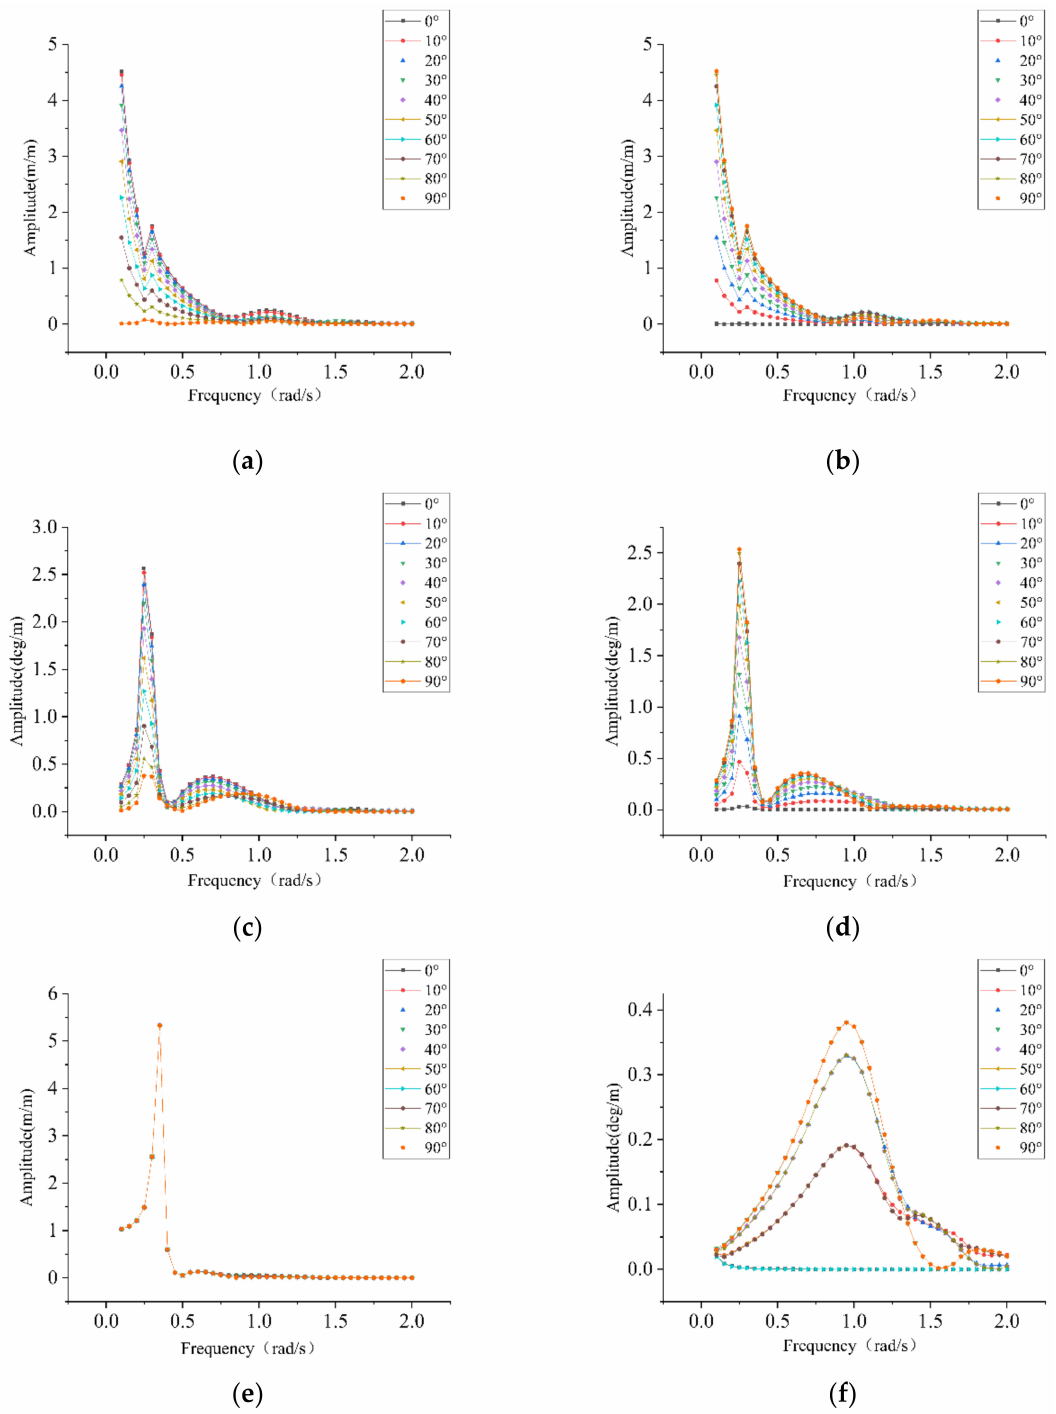
Figure 4. Six degree of freedom response Rao. ( a ) Surge. ( b ) Sway. ( c ) Pitch. ( d ) Roll. ( e ) Heave. ( f )